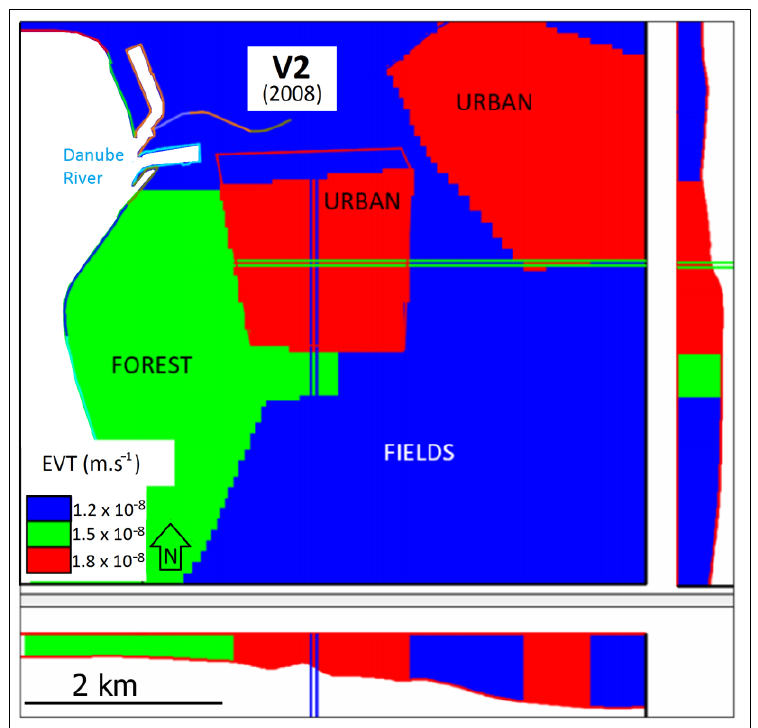
Figure 7. Evapotranspiration zonation with the optimized values within V2 model variant (planar view and vertical cross sections along the blue and green lines).